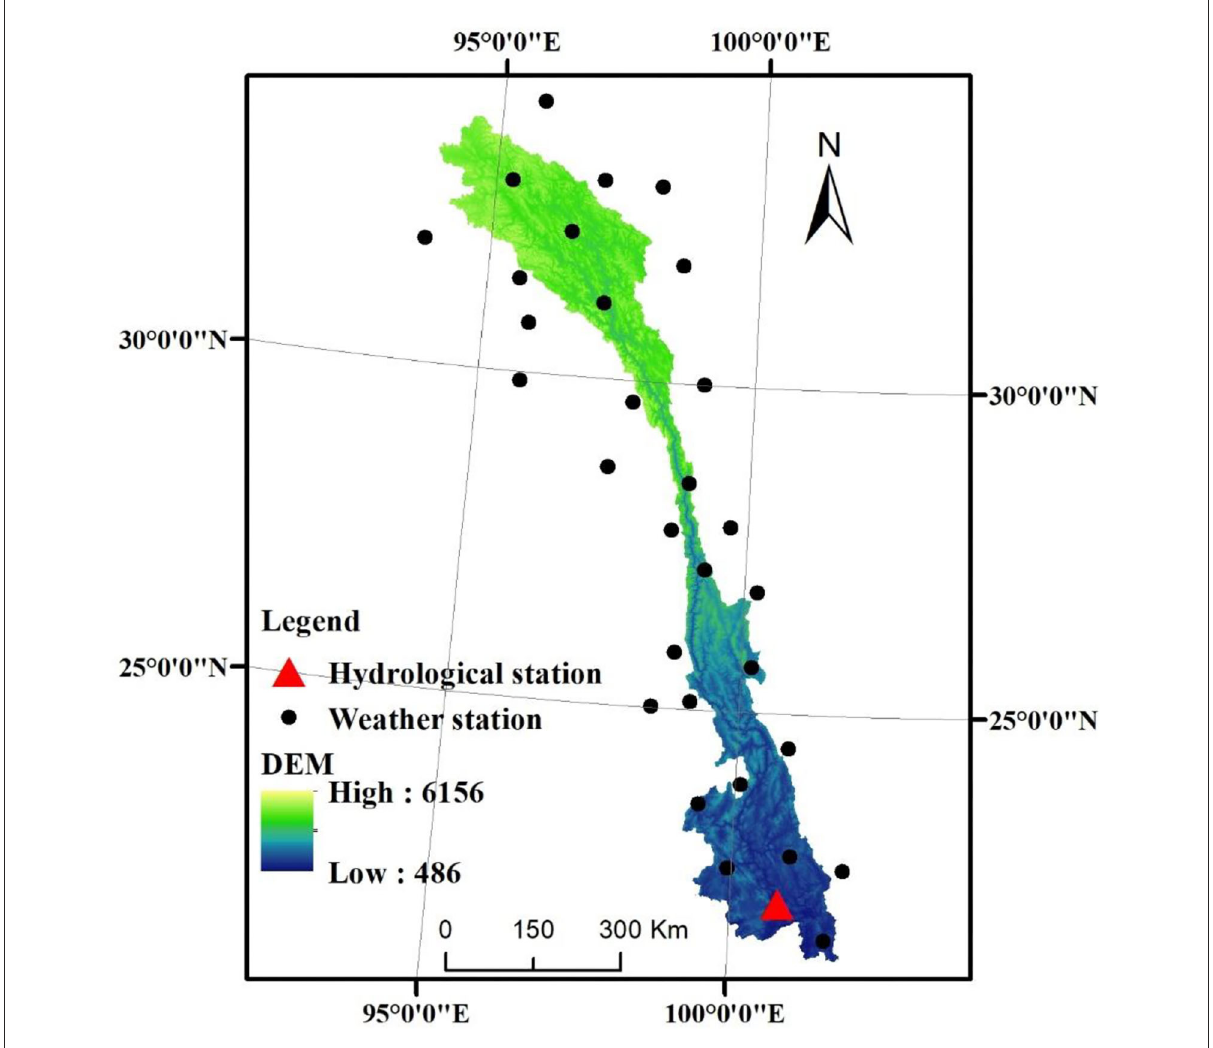
FIGURE1 The location of hydro-meteorological stations in and around the study